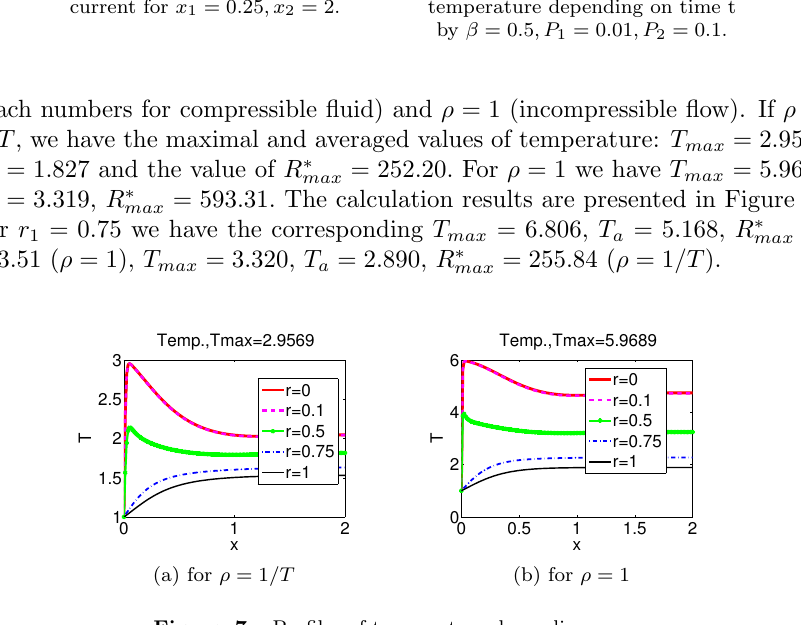
Figure 7. Profiles of temperature depending on x